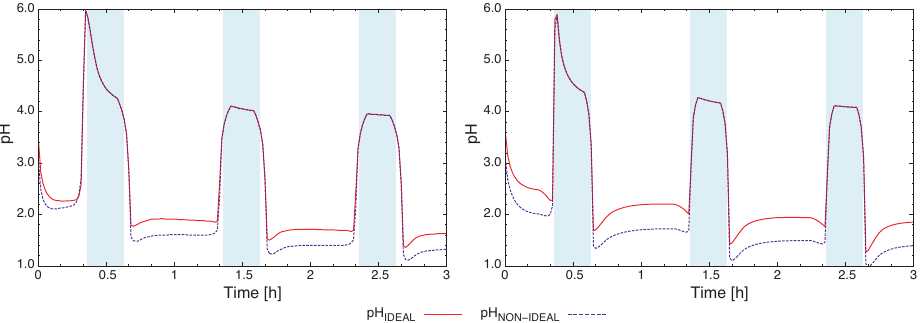
Figure 14. Modeled pH values as the function of the simulation time for the two different relative humidity cases (left: 90%RH; right: 70%RH) considering ideal (red line) and non-ideal (blue line) solutions, respectively. The blue bars mark the in-cloud time periods during the simulation